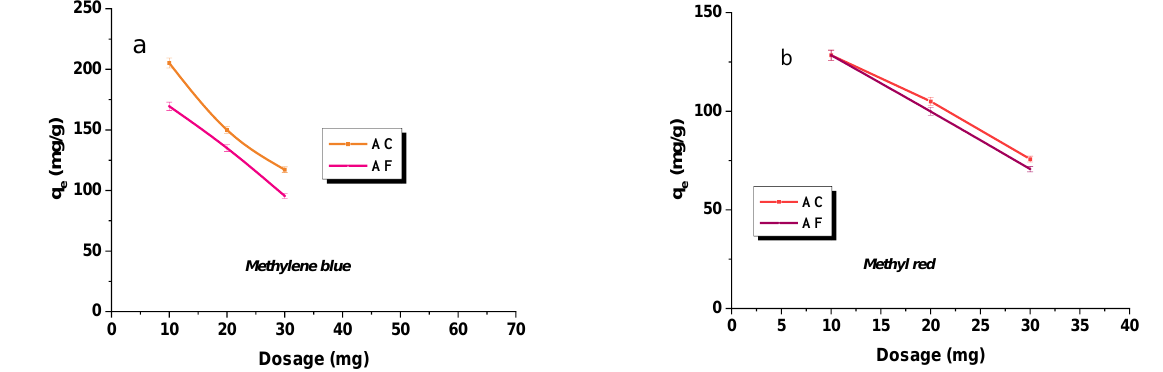
Table 7. Thermodynamic parameters of the adsorption of organic dyes on the activated carbon ad- sorbents studied.